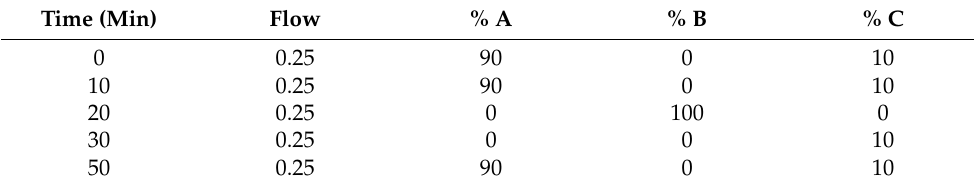
Table 1. Multistep gradient conditions with A—water, B—200 mM NaOH and C—5 mM NaOH. Time (Min) Flow % A % B %